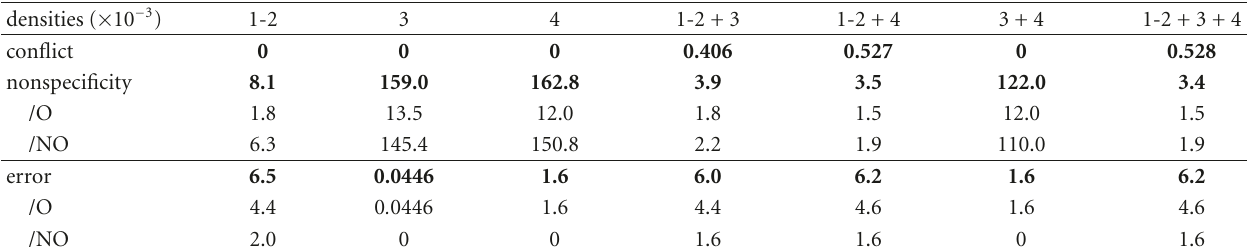
Table 1: Performances of the fusion in image 2, (1-2: mean standard deviation (segmentation), 3: skewness, 4: kurtosis). densities ( × 10 − 3 )